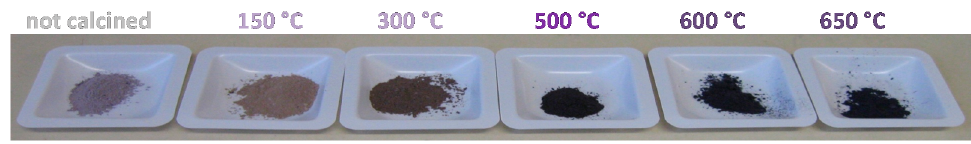
Figure 2. Au/ZrO 2 catalysts calcined at different temperature.